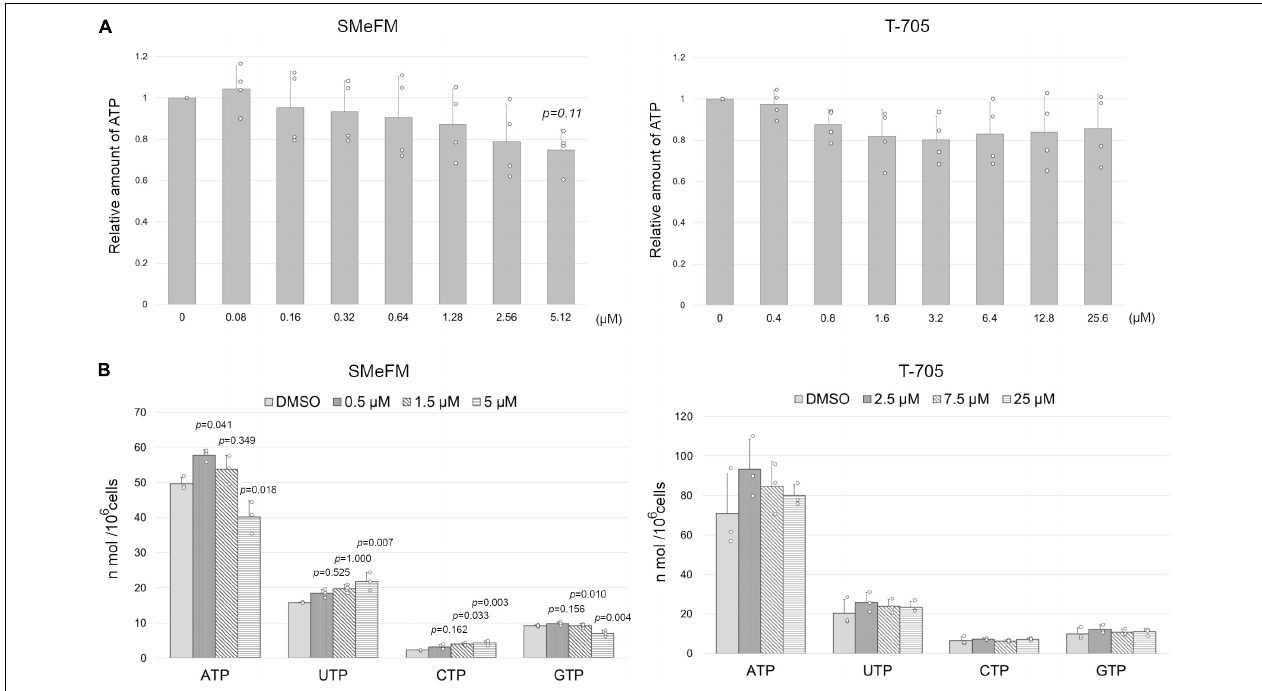
FIGURE 8 | SMeFM treatment reduces the cellular ATP pool. (A) The relative concentration of ATP in cells treated with SMeFM. The cellular ATP concentration was measured as luminescence count and was normalized by the cell number. The relative ATP concentration was calculated by dividing the normalized luminescence count by that of cells without SMeFM treatment which is set as 1. The graph indicates average values with standard deviations from four independent experiments. P -values were calculated by Dunnett’s multiple comparison test. (B) The concentration of NTPs in cells treated with SMeFM. MDCK cells were treated with SMeFM or T-705 at indicated concentrations, and NTP concentration was analyzed by HPLC. The graph indicates average values with standard deviations from three independent experiments. The circles indicate the value of each experiment. P -values were calculated by Dunnett’s multiple comparison